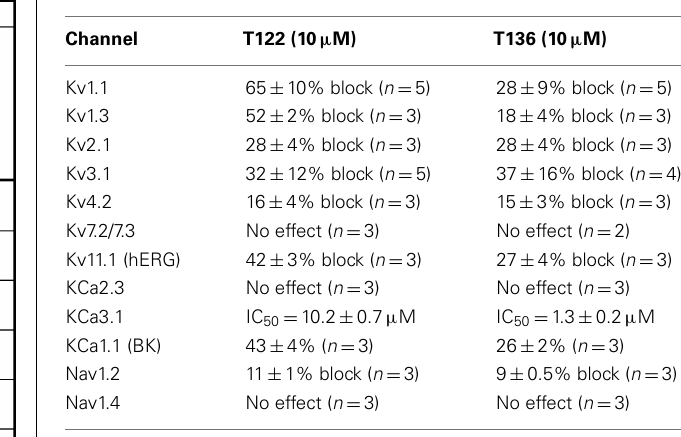
Table 1 | Selectivity over other ion